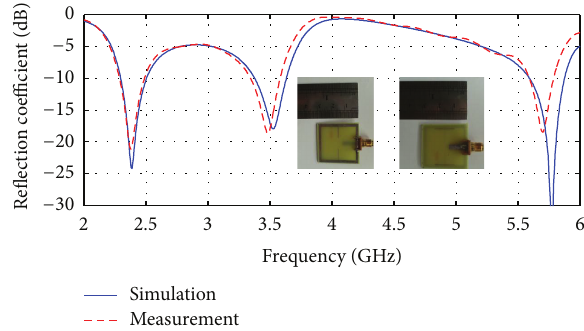
Figure 7: Simulated and measured reflection coefficient characteristic of proposed antenna